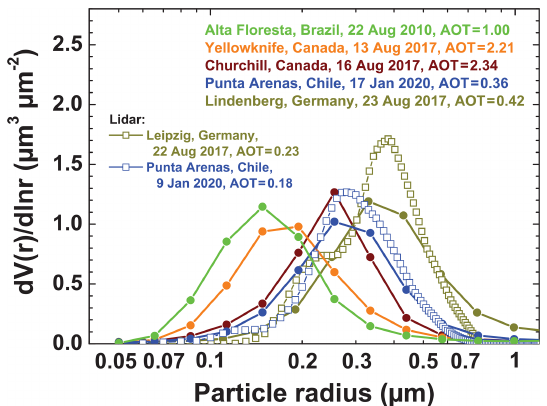
Figure 4. Comparison of normalized volume size distributions of smoke particles highlighting the shift of the size distribution to- wards larger particles with age of the observed smoke. The Ama- zonian smoke size distribution (Alta Floresta, green) is indicative for rather fresh smoke. Canadian smoke over Yellowknife (orange), Churchill (red), and Lindenberg (brown) was observed 1, 3–4, and 10–11d after injection of smoke into the UTLS. The Punta Arenas observation (blue) was taken after about 8d of long-range trans- port. The stratospheric size distributions obtained from lidar obser- vations (open symbols, Punta Arenas, Leipzig) match well with the respective AERONET observations at Punta Arenas and Linden- berg (about 180km northeast of Leipzig). The accumulation-mode radius shifted from 150–200nm (Yellowknife) to 300–400nm (Lin- denberg) within the 9d travel of the 2017 smoke plumes from Yel- lowknife in Canada to Germany.